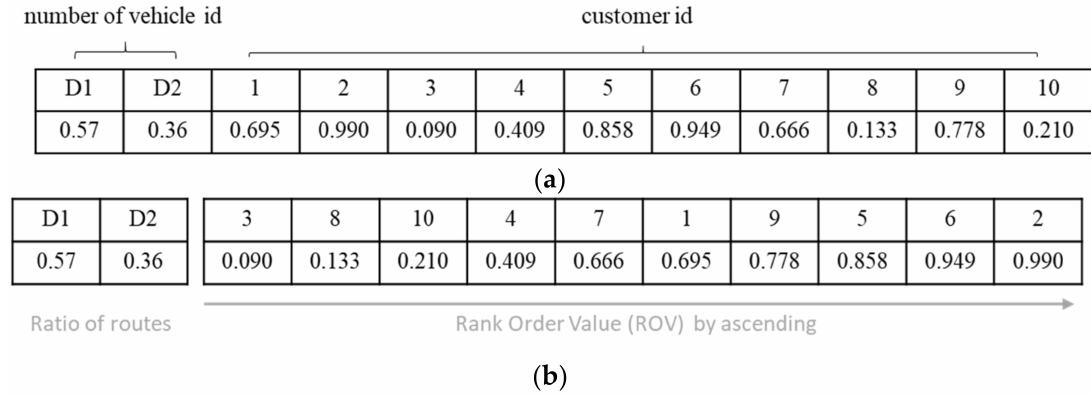
Figure 4. The vector initialization. ( a ) HSADE vector; ( b ) Customer sequence and